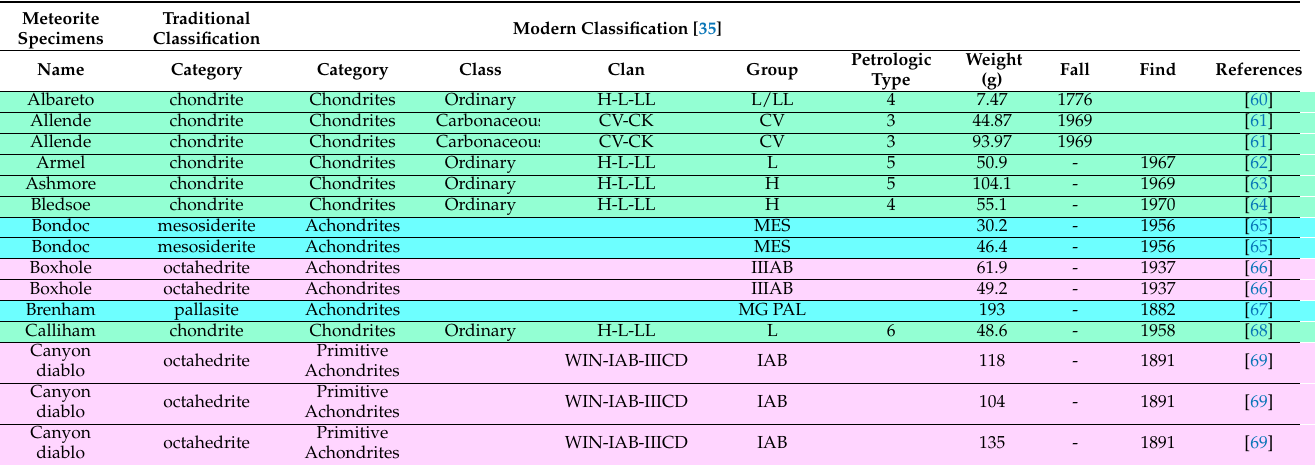
Table A1. List of meteorite specimens hosted by the Meteorite collection of University of Perugia (Italy), classified following the scheme proposed by Weisberg et al. (2006)